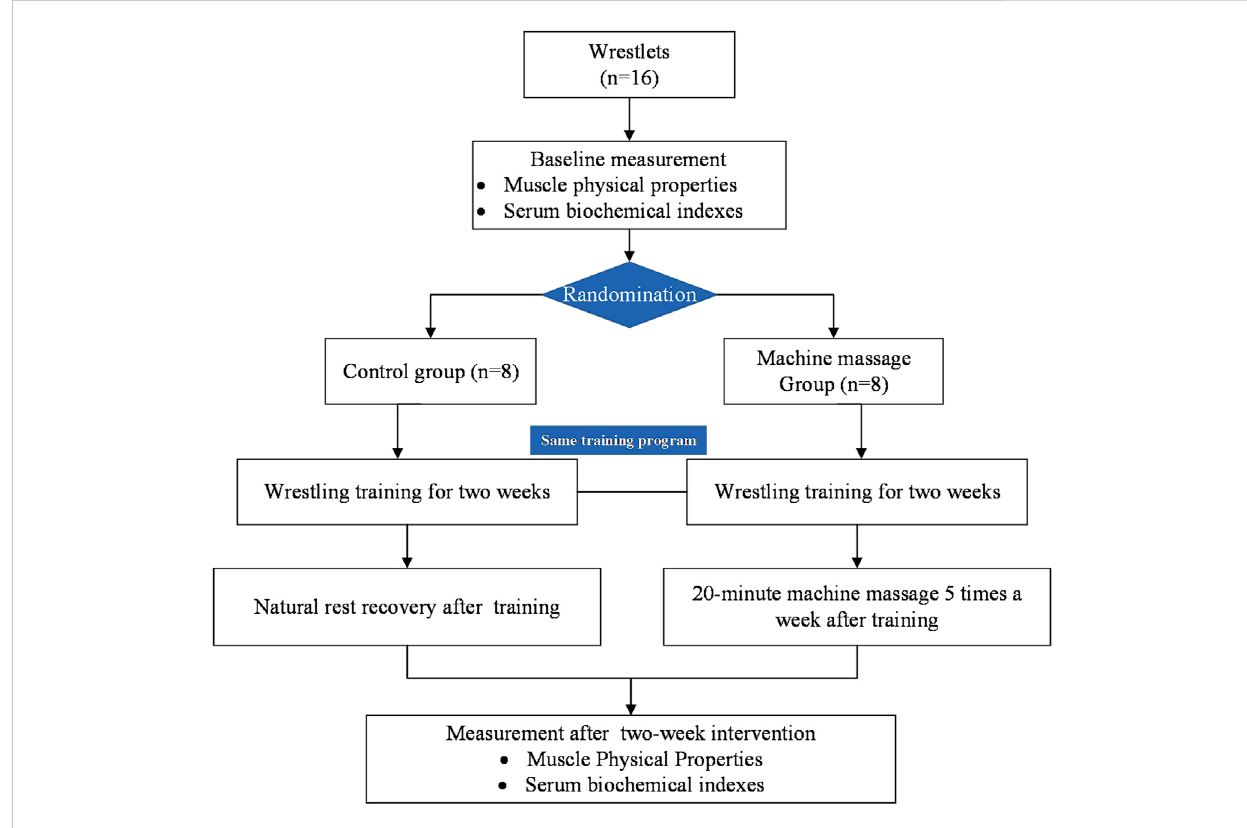
FIGURE 1 Flow-chart of the